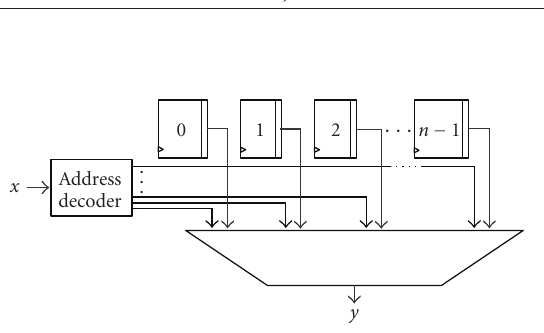
Figure 4: Array read access in